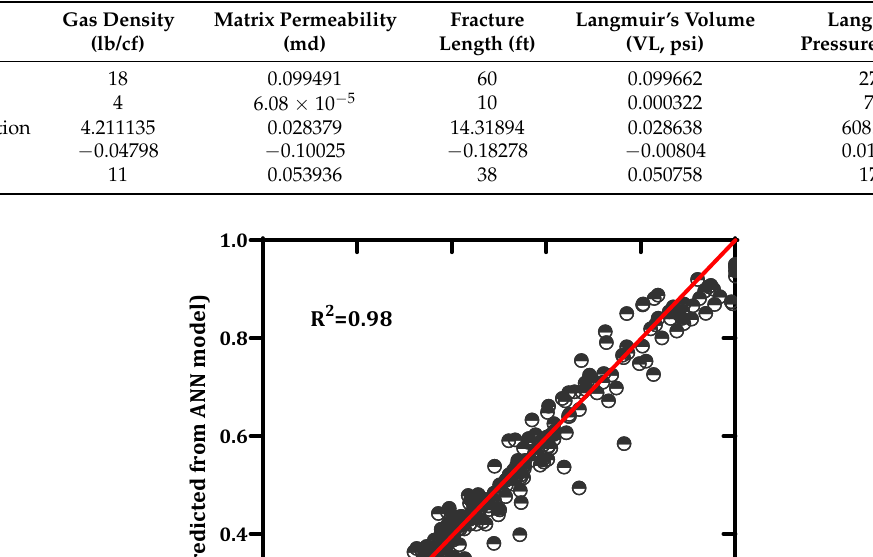
Table 3. Statistics analysis of the input data.